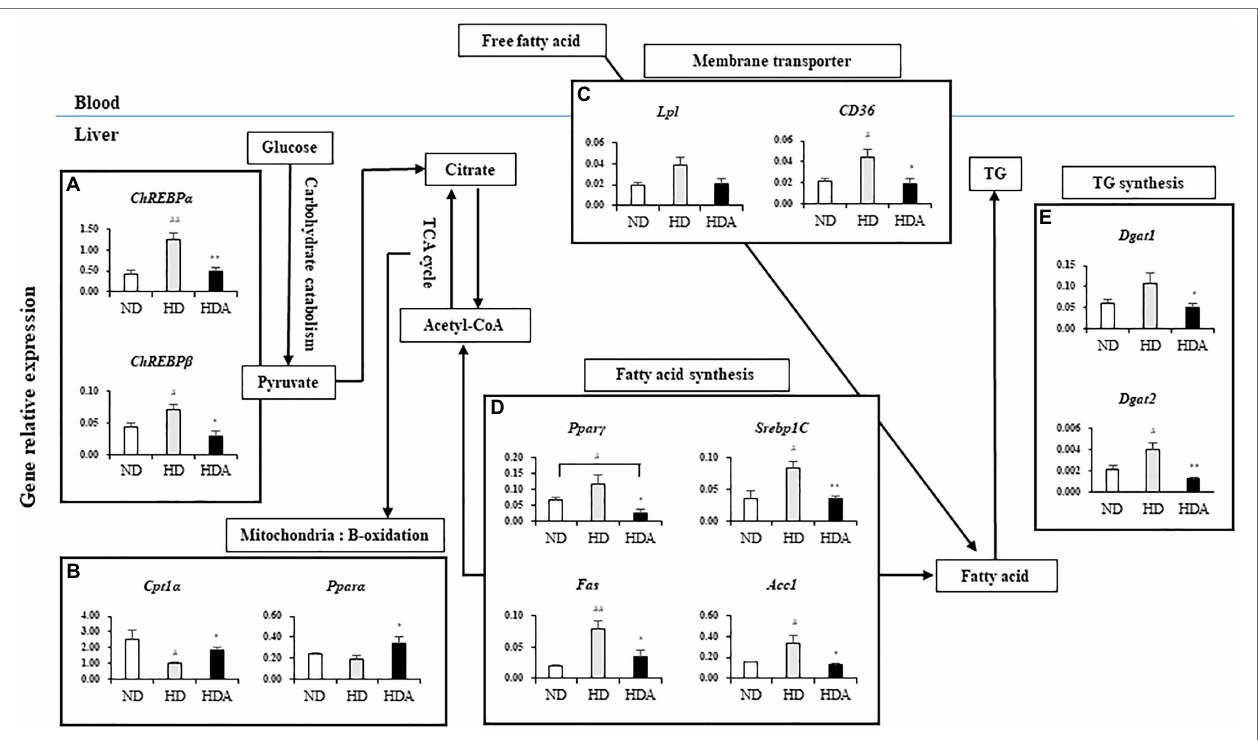
FIGURE 3 | Effects of administered L. sakei ADM14 on the transcription of genes related to glucose and lipid metabolism in the liver. The results are shown as mean ± SEM ( n = 5). Significant differences between HD and ND are indicated as # p < 0.05 and ## p < 0.01. Significant differences between HDA and ND are indicated as # p < 0.05 and ## p < 0.01. Significant differences between HD and HDA are indicated as * p < 0.05 and ** p <